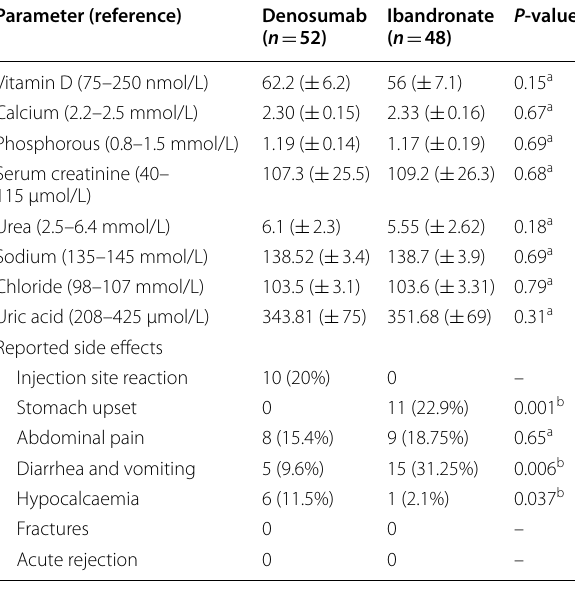
Table 1 Baseline characteristics of the participants Table 2 The average levels of the participants characteristics after one year of treatment